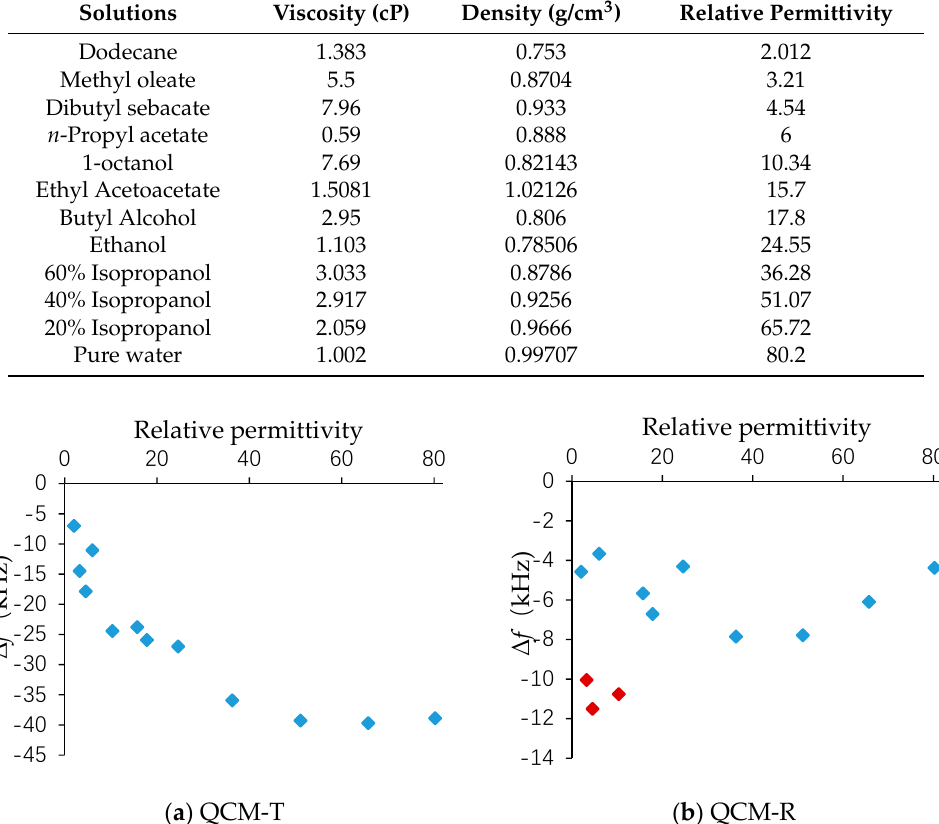
Table 2. Experimental organic solution characteristics (25 ◦ C).